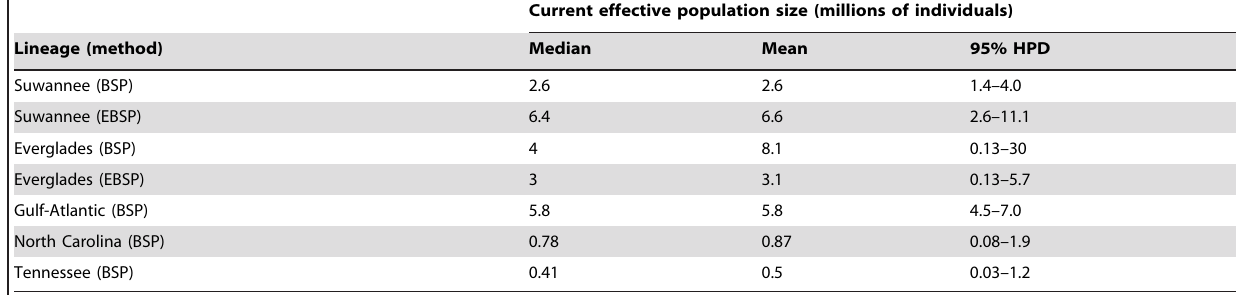
Current effective population size (millions of individuals)